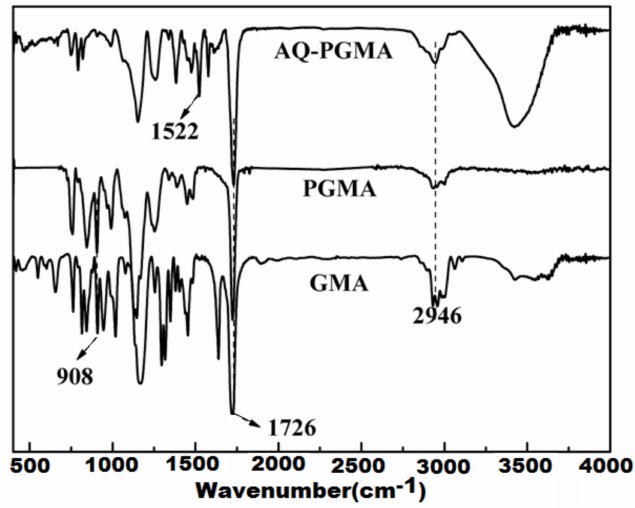
Figure 1. Fourier transform-infrared (FT-IR) spectra of glycidyl methacrylate (GMA), poly(glycidyl methacrylate) (PGMA) and 8-aminoquinoline-grafted poly(glycidyl methacrylate)